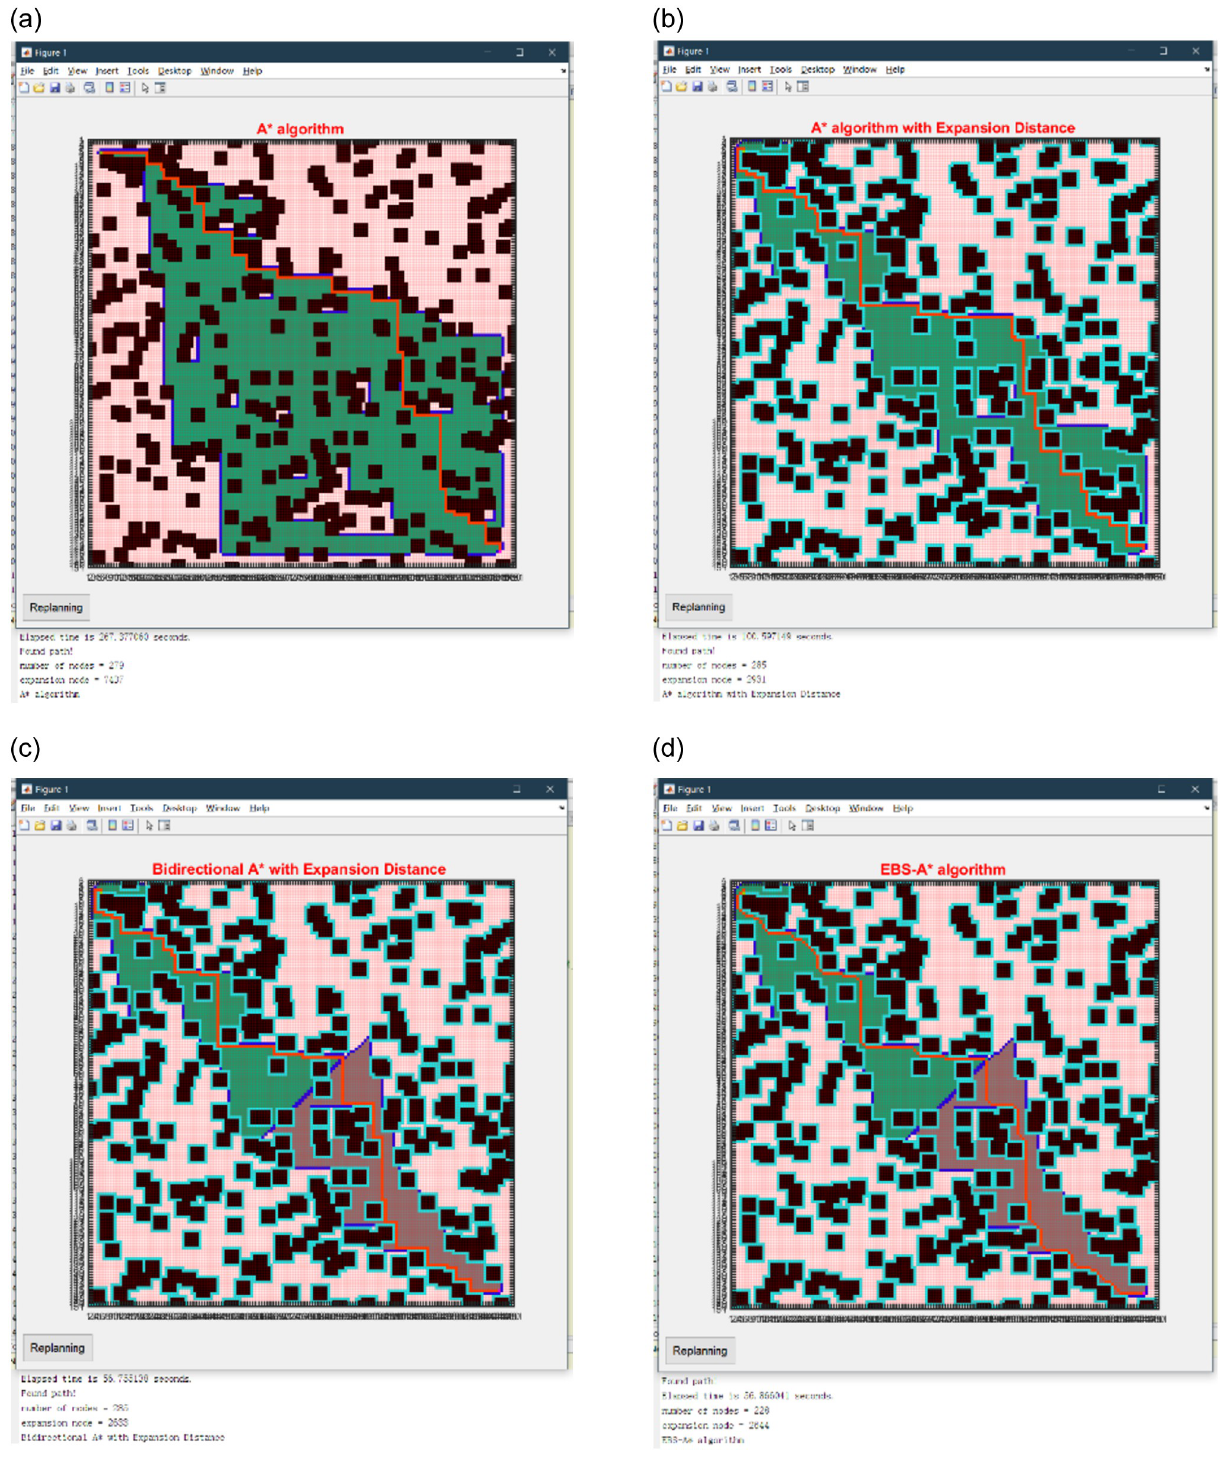
Fig 9. Simulation results of four algorithms on a 150 × 150 map. (a) A � algorithm. (b) A � with expansion distance. (c) Bidirectional A � with expansion distance. (d) EBS-A � algorithm.